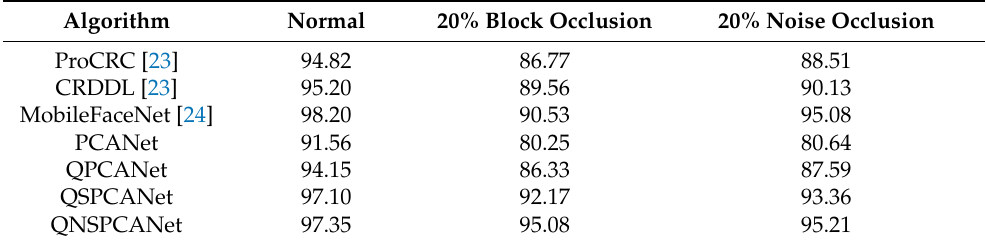
Table 4. The correct recognition rate of each algorithm in LFW-A dataset under different occlusion conditions (%).